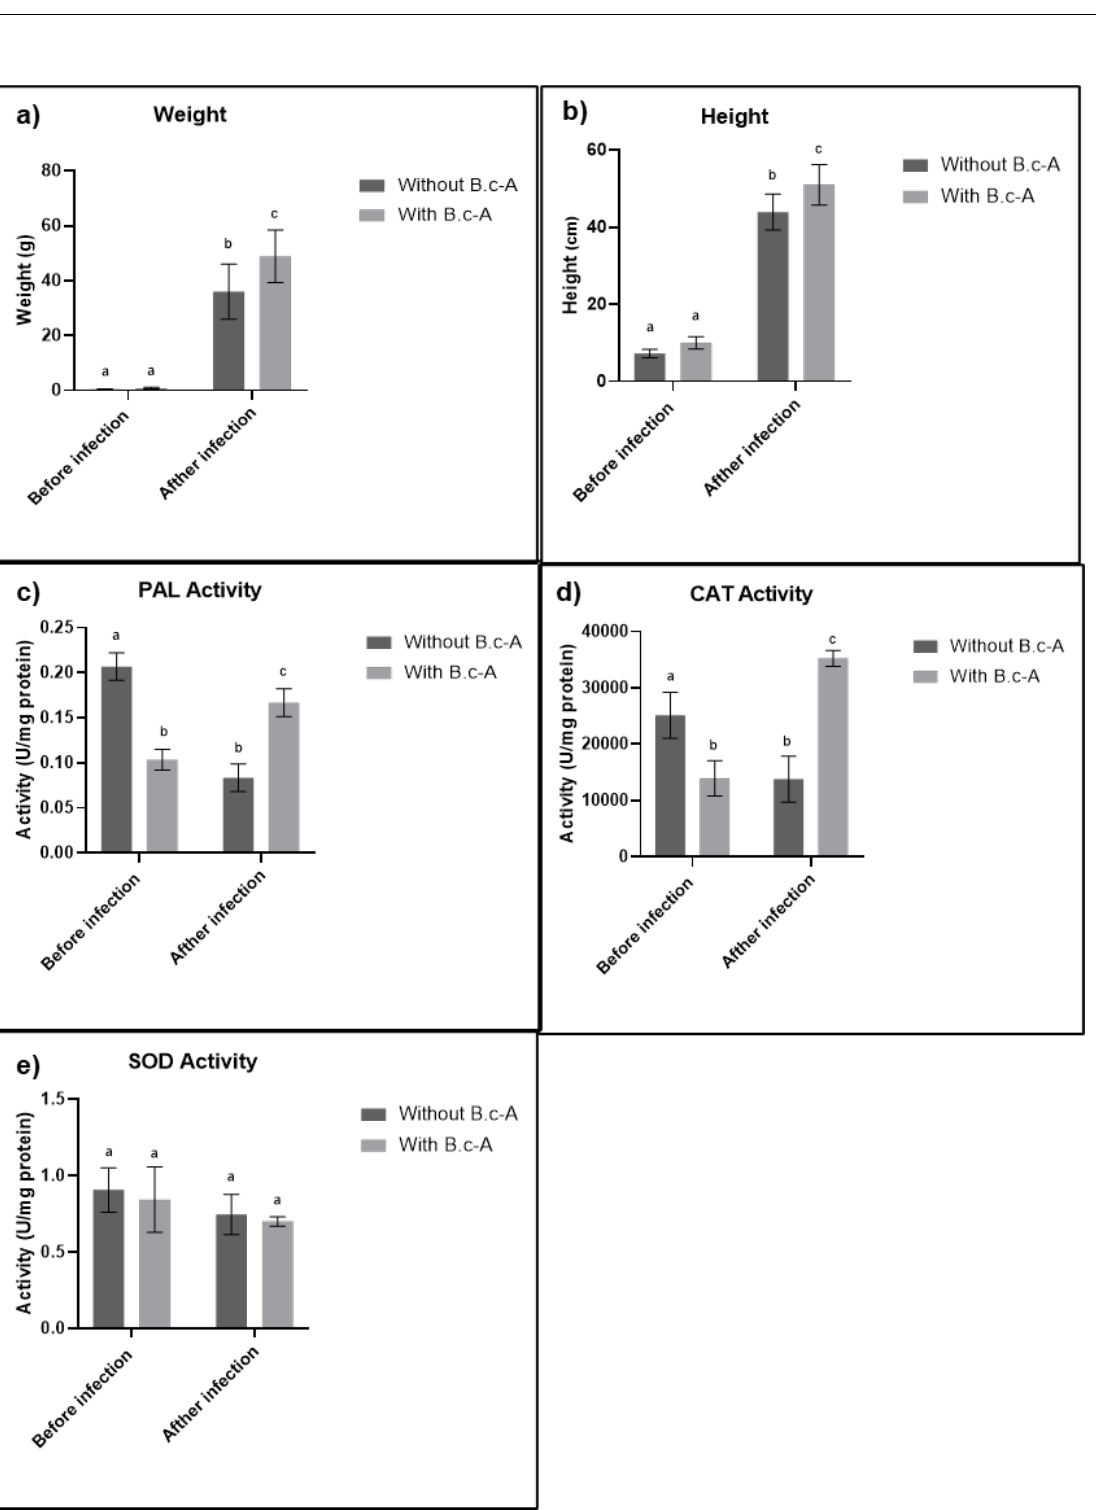
Figure 2. Weight ( a ), height ( b ), and enzymatic activity ( c – e ), of 30-day-old plants with and without the inoculation of B. c -A, before and after infection with Cmm (equal letters indicate that there is no statistically representative difference).